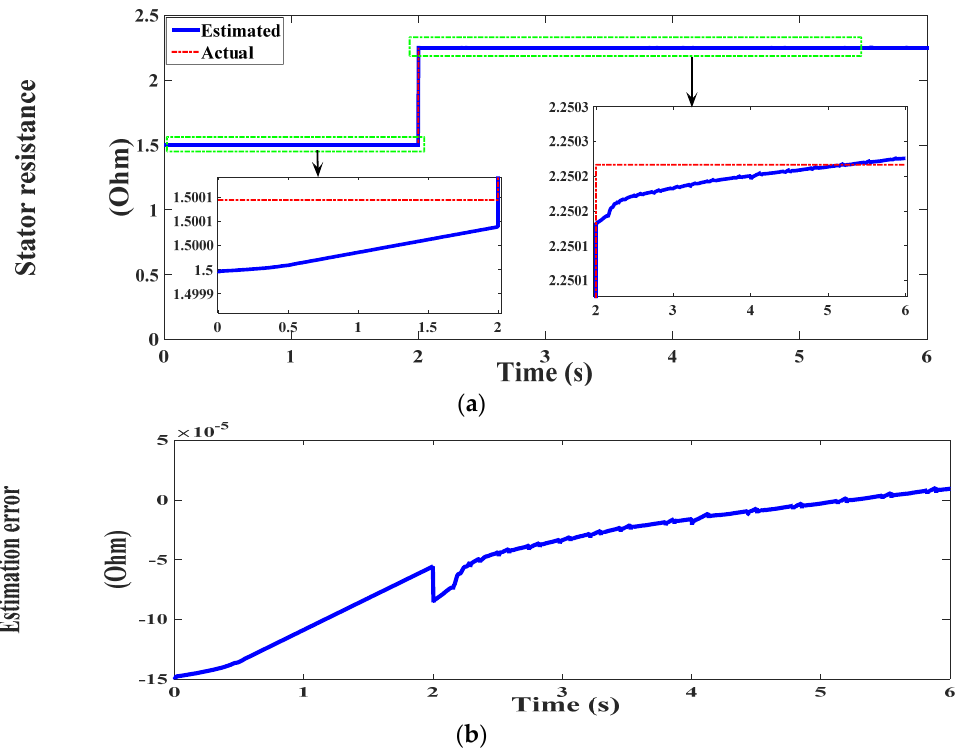
Figure 19. ( a ). Stator resistance variation under PVC ( Ω ), ( b ). Rs estimation error under PVC ( Ω ).